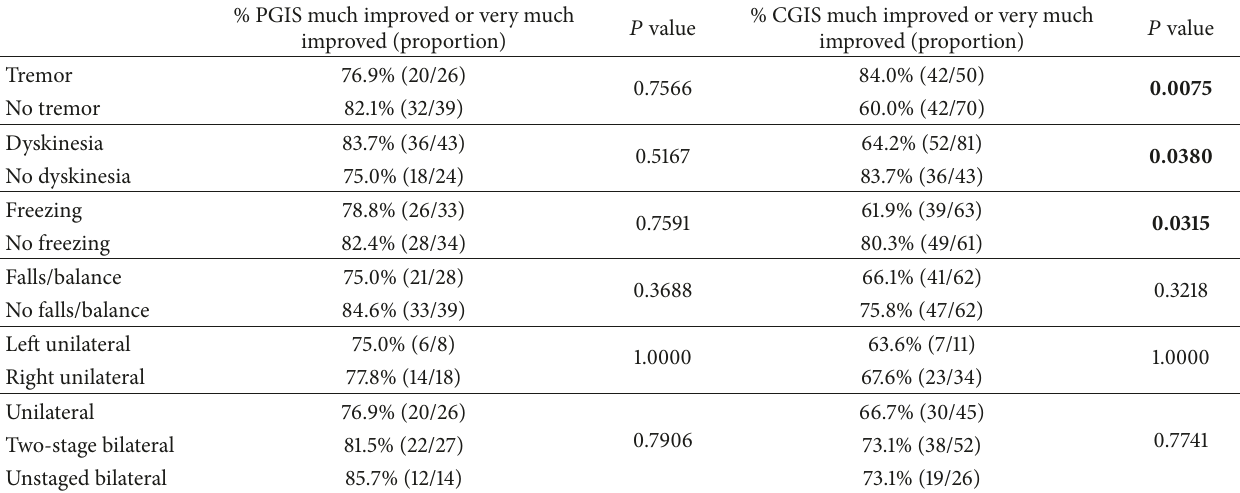
Table 2: Patient Global Impression of Change Scale (PGIS) and Clinician’s Global Impression of Change Scale (CGIS) results by various categorical